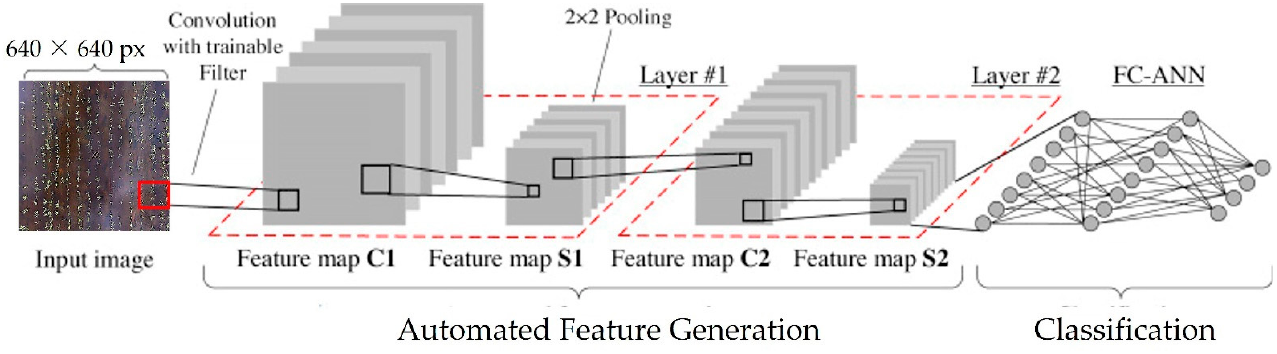
Figure 4. The overview of feature extractor structure. Table 2. Properties of the selected feature extractor.